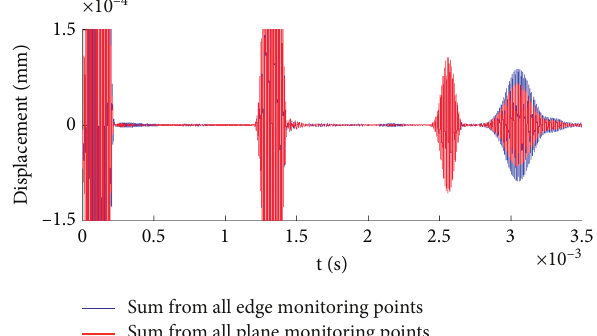
Figure 11: Sum of the time domain waveforms received from 6 edge and 6 plane monitoring